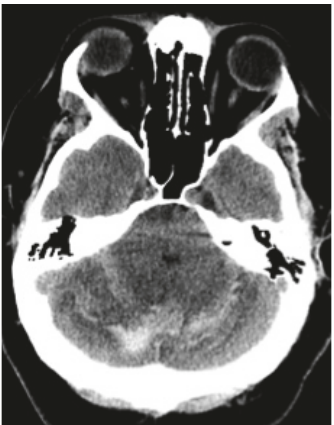
Figure 2: Nonenhanced CT head image at the level of the cerebellum demonstrates acute haemorrhages in both cerebellar hemispheres (arrow) with edema, causing mass effect on the fourth